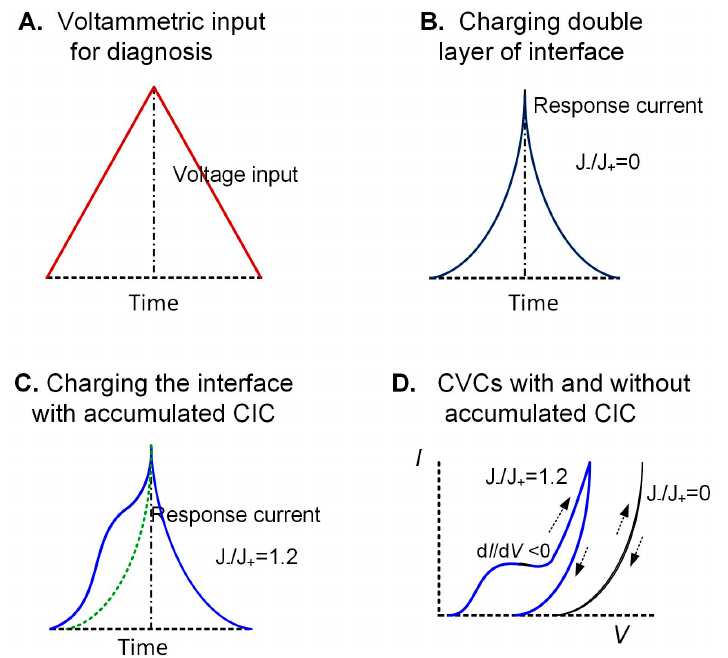
Figure 2. Schematic diagrams showing the effects of cathodic current on the response of voltammetric diagnosis input. Reprinted with permission from [34]; Copyright 2019 Elsevier. The schematic diagrams show ( A ) the voltammetric diagnosis input pulse of two constant scan rates of ascending and descending voltage; ( B ) the response voltammetric current of a plasma electrolytic oxidation (PEO) coating prepared by zero cathodic current; ( C ) the response voltammetric current of a PEO coating prepared by negative current higher than positive current; ( D ) the current–voltage response curves (CVCs) of two PEO coatings prepared with and without cathodic current.